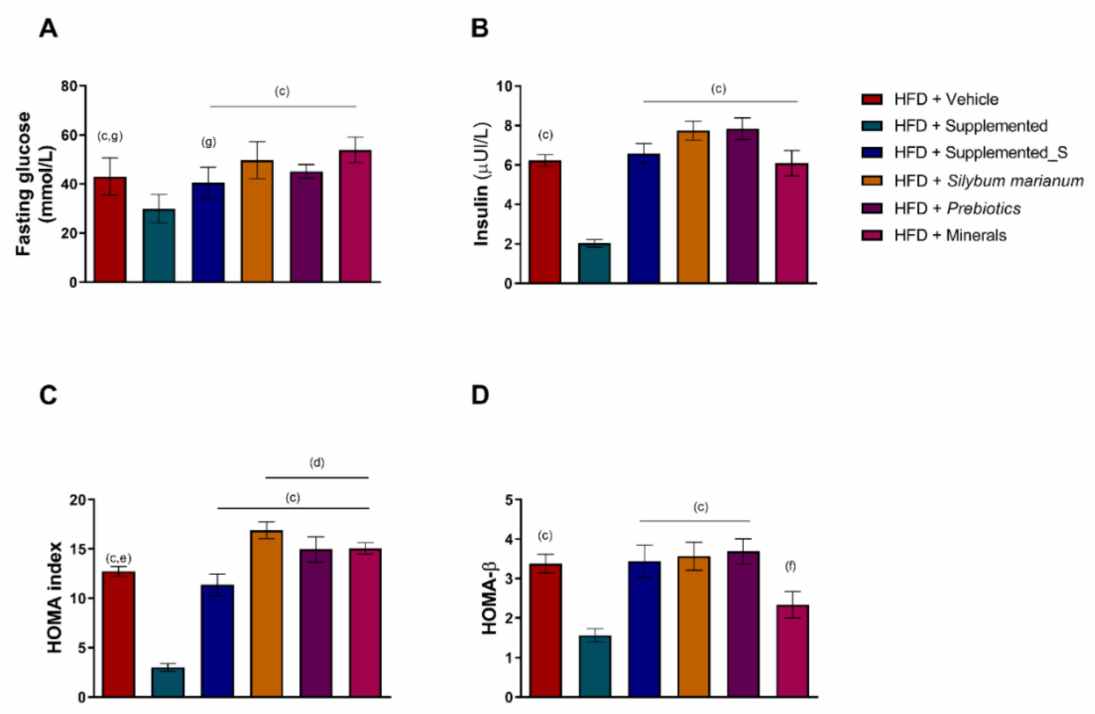
Figure 4. Insulin sensitivity tests. ( A ) Fasting glucose, ( B ) fasting insulin, ( C ) HOMA index, and ( D ) HOMA- β . Significant p < 0.05 in one-way ANOVA followed by Tukey’s post-hoc test (n = 4–8 per group): (c) versus HFD + Supplemented; (d) versus HFD + Supplemented_S; (e) versus HFD + Silybum marianum ; (f) versus HFD + Prebiotics, and (g) versus HFD + Minerals. HFD = high-fat diet. Values are means ±